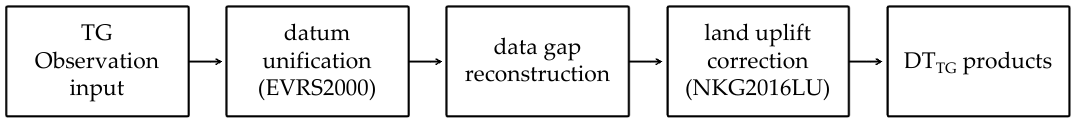
Figure 5. Steps for TG observation data reconstructions and corrections.